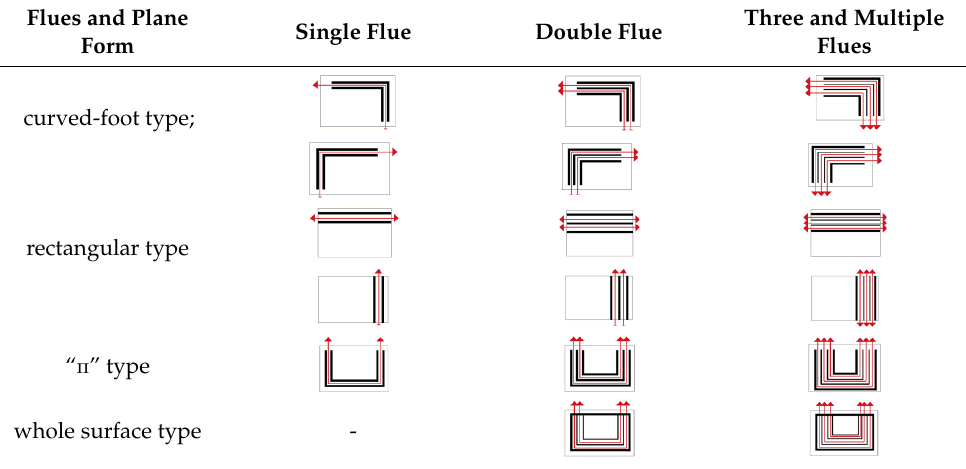
Table 5. Hypocaust shape classification.